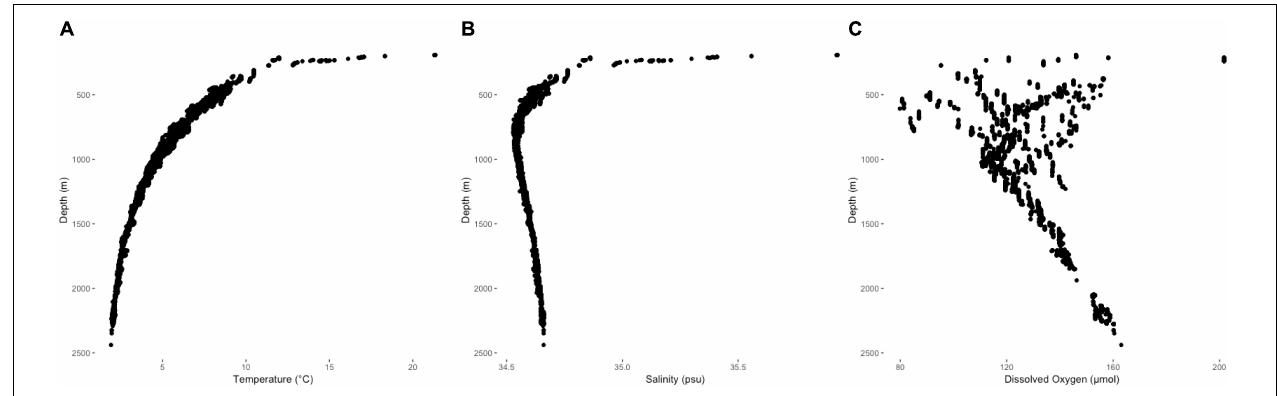
FIGURE 4 | Temperature (A) , salinity (B) , and dissolved oxygen (C) profiles from ROV CTD unit records co-occurring with deep-water coral observations between 193 and 2439 m.